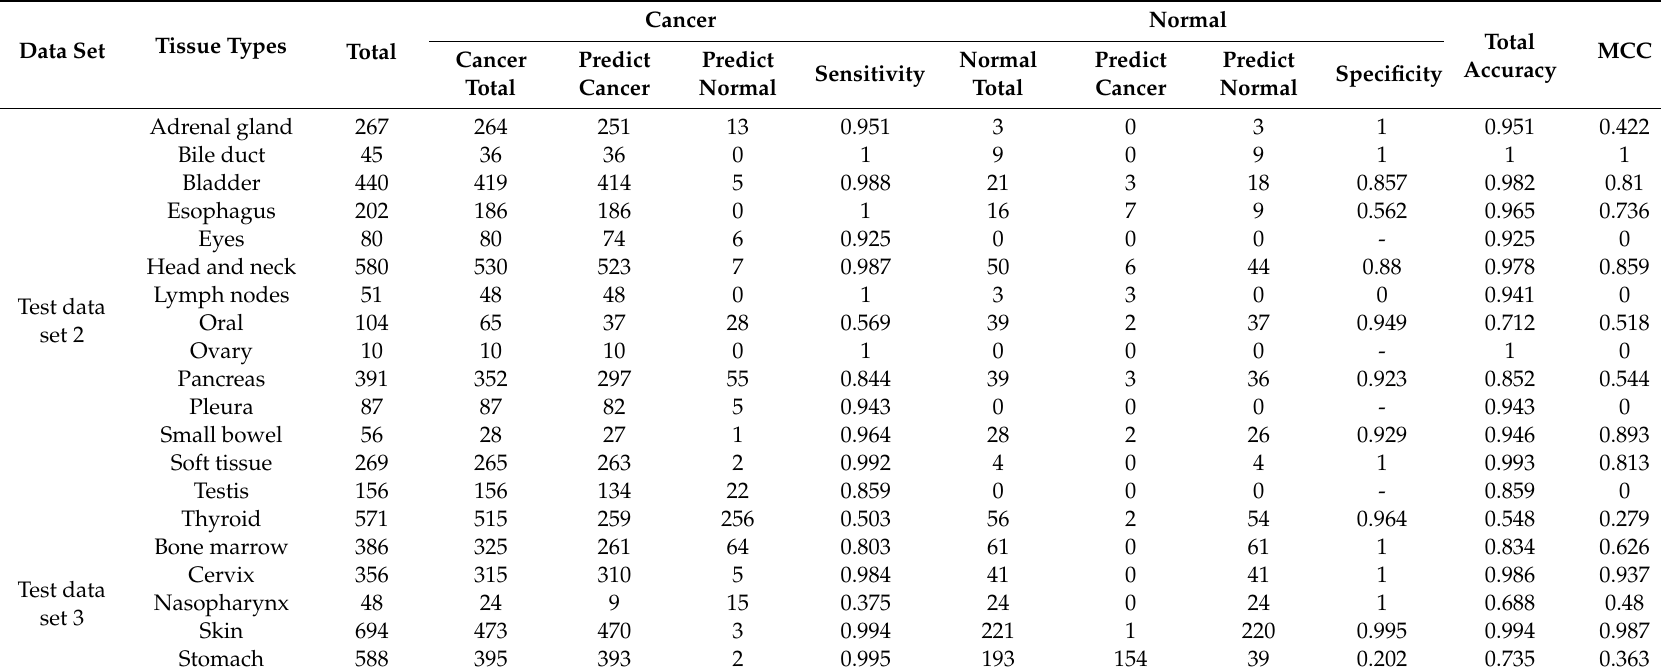
Table 7. The prediction results of two test data sets for 13 promoter